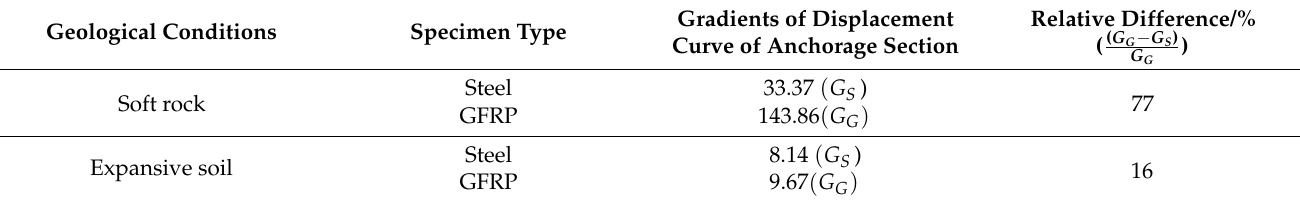
Table 7. Statistics of relative difference of various